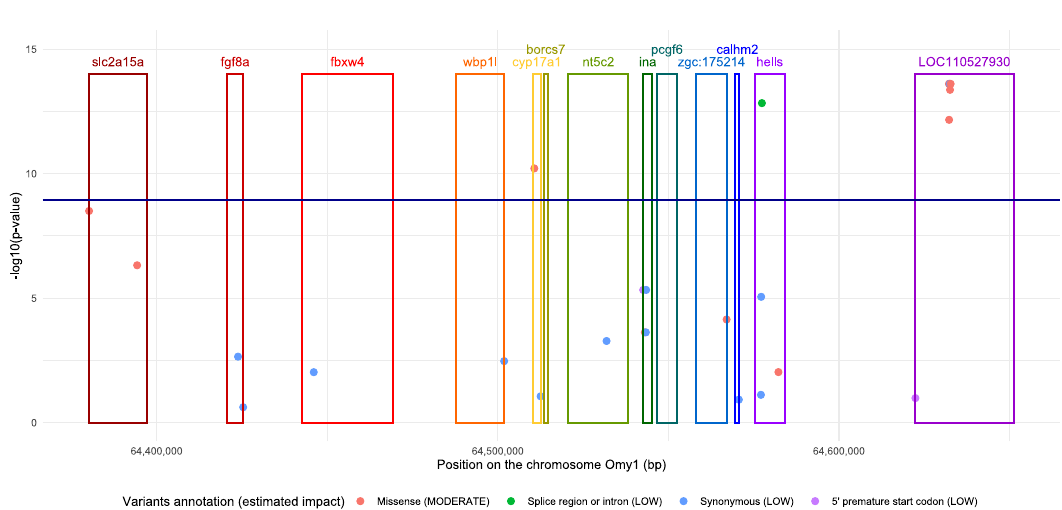
Figure 2. Annotated SNPs located within the first QTL region from 63.549 to 63.556 Mb on Omy1. The significance of SNP effect (dots) is given by the value of – log 10 (p-value) estimated with the GCTA-seq method. The dark blue line corresponds to the 1% threshold at the genome wide level. Only SNPs with at least low putative effects on genes (estimated by SNPEff) are represented. The positions of the five genes located within the QTL region are figured by rectangles: banf1 (barrier-to-autointegration factor-like), pygb (glycogen phosphorylase, brain form), abhd12 (alpha/beta-Hydrolase domain containing 12), gins1 (DNA replication complex GINS protein PSF1), ninl (ninein-like protein).